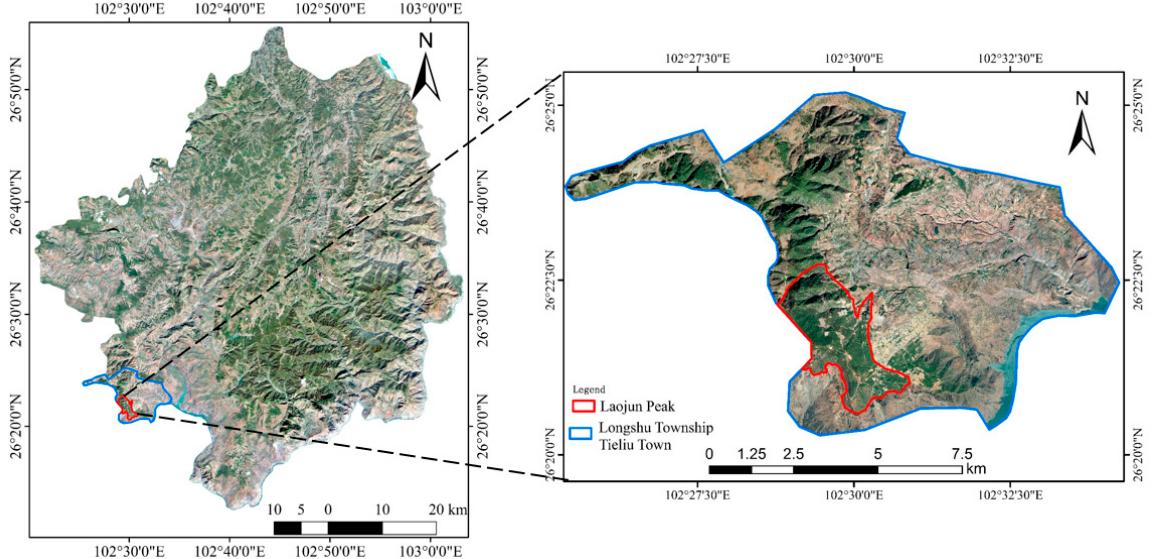
Figure 1. Satellite images of the study area: Huidong County, Sichuan Province ( left ) and Laojun Peak Scenic Area, Huidong County ( right ).